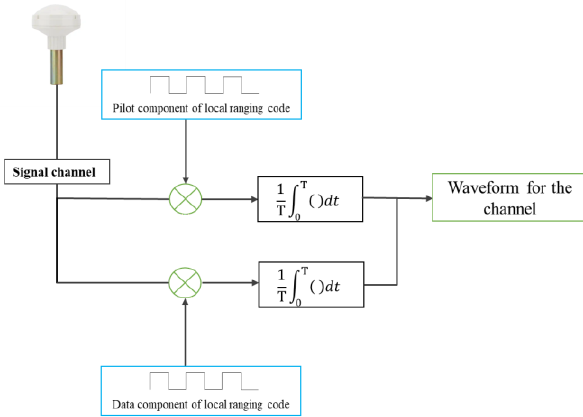
Figure 4. The IF data acquisition and process for one channel.